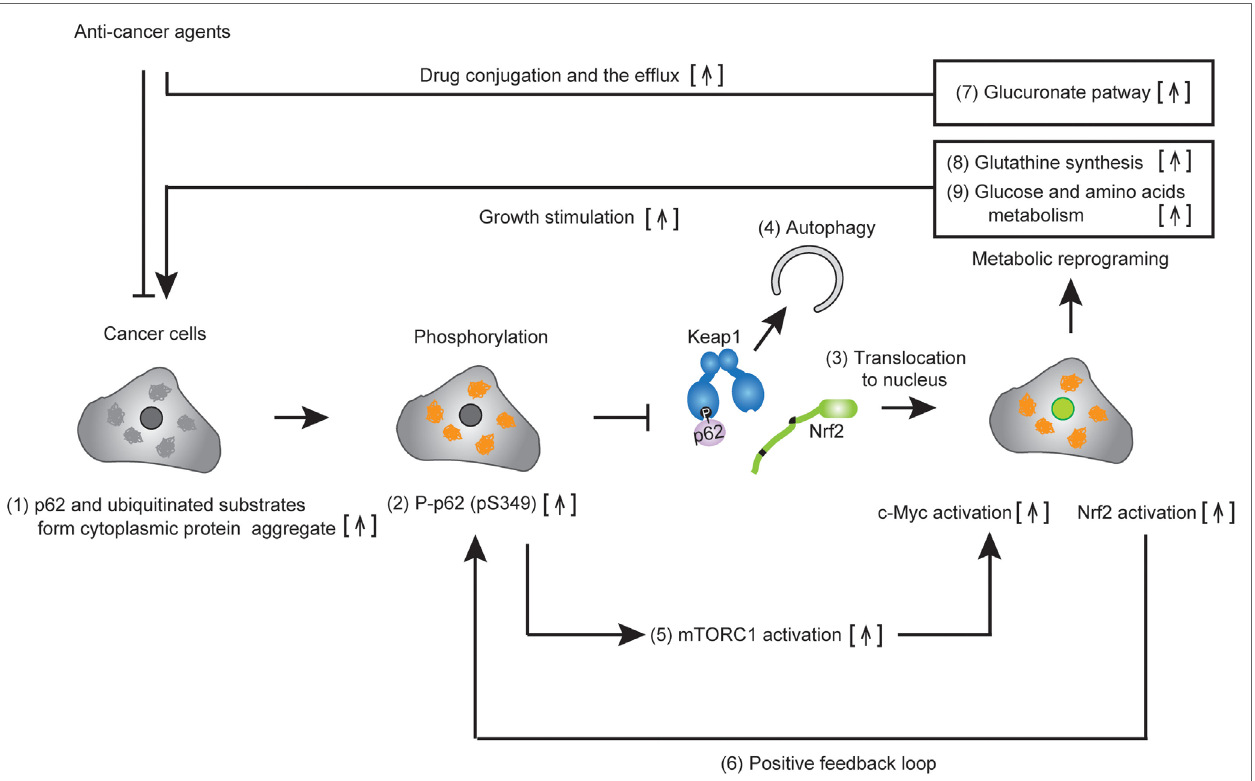
FigURe 4 | Metabolic reprogramming of cancer cells harboring phospho-p62. Accumulated p62 and ubiquitinated substrates form cytoplasmic protein aggregates in established tumor cells (1). The p62 localized in the protein aggregates are phosphorylated at serine 349 (2). Then, DLGex of nuclear factor erythroid 2-related factor 2 (Nrf2) is competitively displaced by phosphop-p62, which causes the dissociation of Nrf2 from Keap1. Nrf2 translocates to the nucleus and activates Nrf2-mediated gene expression (3), while the resulting p62–Keap1 complex is removed by p62-dependent selective autophagy (4). Increased p62 positively regulates c-Myc activity via the activation of mechanistic target of rapamycin complex 1 (5). Persistent activation of Nrf2 occurs due to the positive feedback loop of Nrf2 in cancer cells (6). Nrf2 activation induces metabolic reprogramming, including the glucuronate pathway (7) and glutathione synthesis (8), while c-Myc enhances glucose and glutamine metabolism (9). The activation of multiple metabolic pathways permits the drug resistance and cell proliferation of